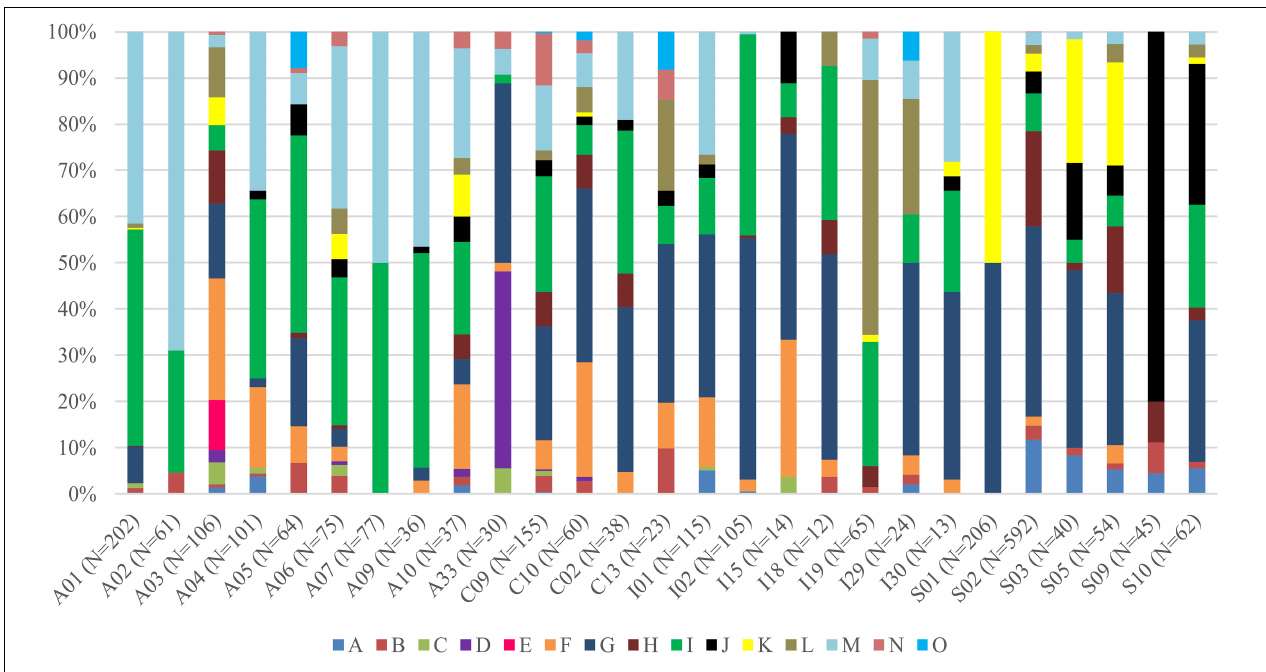
FIGURE 8 | Bar graphs of selected Trebouxia photobiont OTUs showing the percentage occurrence of particular groups of lichen secondary metabolites found in lichen thalli. Symbols A–O correspond to groups of secondary metabolites: no substances (A), presence of aliphatic (fatty) acids (B), anthraquinones (C), ergochromes (D), depsones (E), orcinol depsides (F), β -orcinol depsides (G), orcinol depsidones (H), β -orcinol depsidones (I), orcinol tridepsides (J), pulvinic acid derivative (K), terpenoids (L), usnic acid derivatives (M), xanthones (N), and pigments